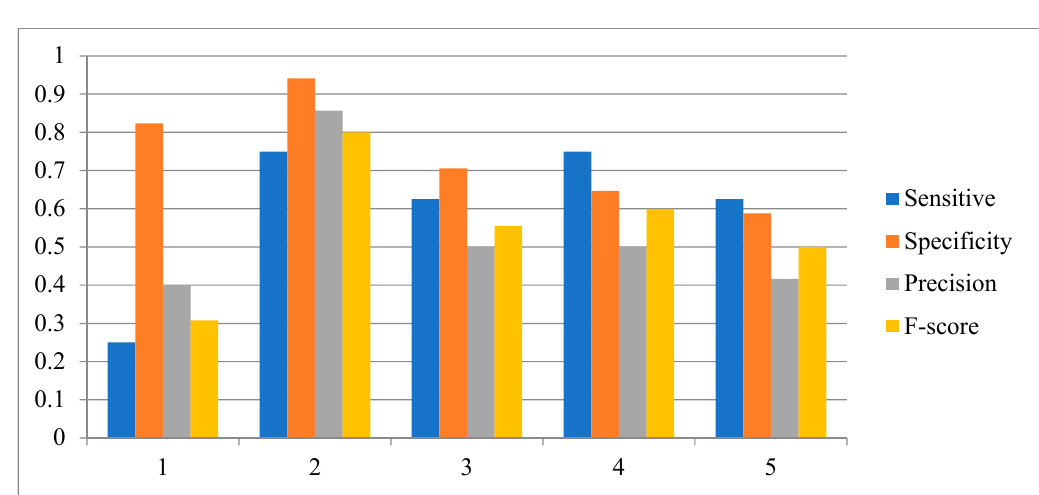
Figure 11. Effect of parameter L for IRMA network inference with on dataset.